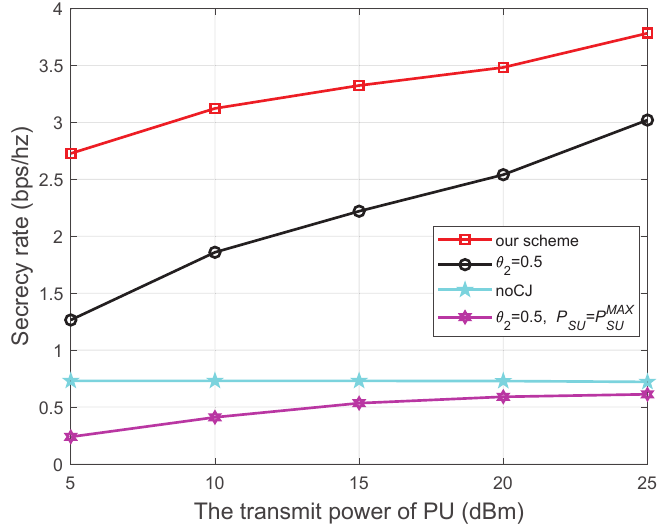
Figure 3. The secrecy rate versus transmit power of PU.